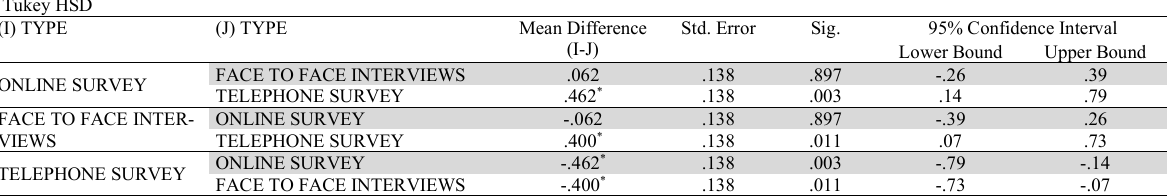
Multiple Comparisons of Promotion schemes